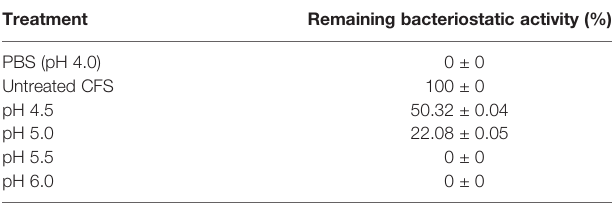
TABLE 2 | Bacteriostatic activity of the CFS against E. coli ATCC 25922 by different pH treatments.